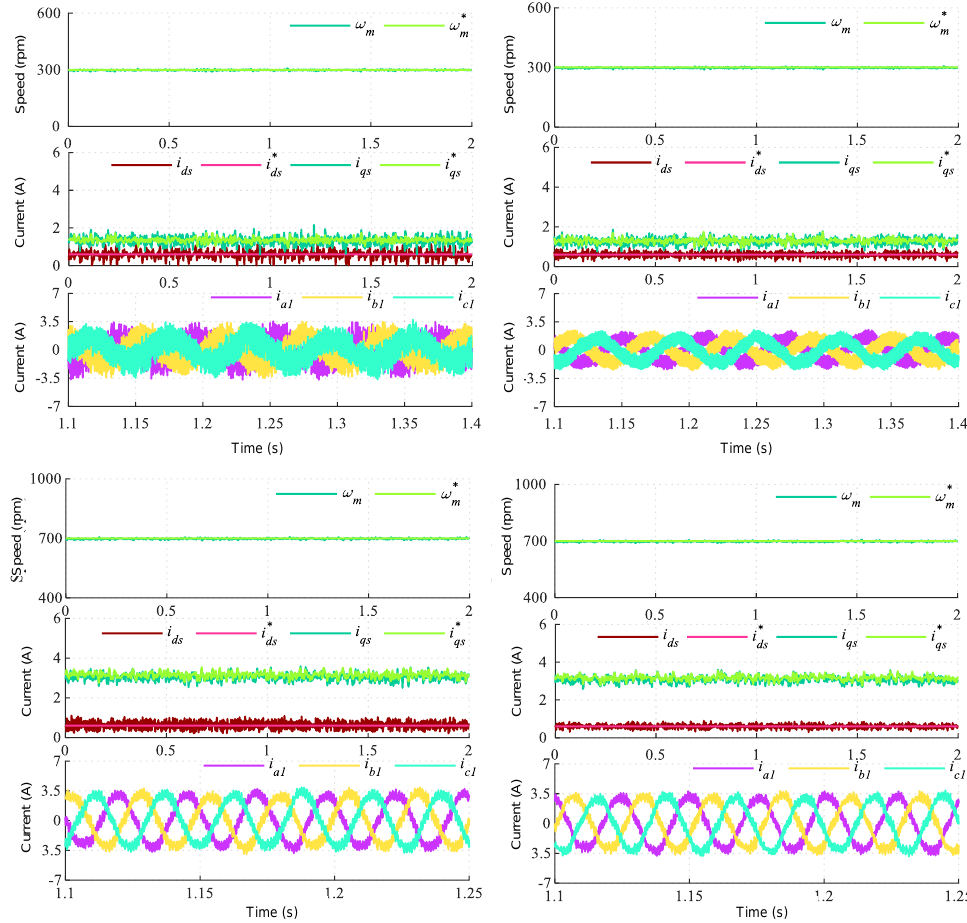
corresponds to C3. An improvement in current regulation is observed when using the proposal.